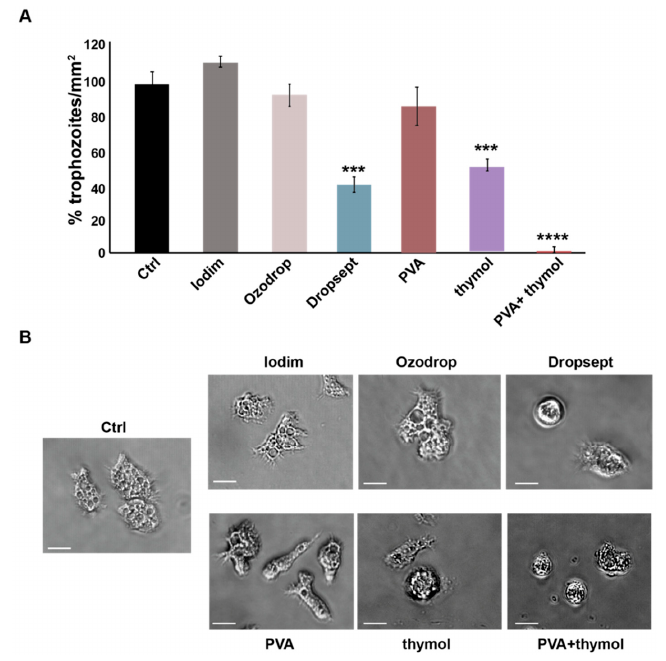
Figure 2. Antiparasitic activity of the ophthalmic solutions . ( A ) Histograms of the number of Acanthamoeba castellanii trophozoites/mm 2 exposed to the highest concentrations of each formulation and pictured at 10 × magnification. Each formulation was expressed as % of the control (Ctrl, 100%). ( B ) Images of conditions in ( A ) at 40 × magnification reveal that the shape of amoeba was particularly compromised in presence of Dropsept and PVA + thymol. Scale bar—10 µ m. The results are presented as mean ± SD. t -test *** p < 0.001, **** p < 0.0001 vs.